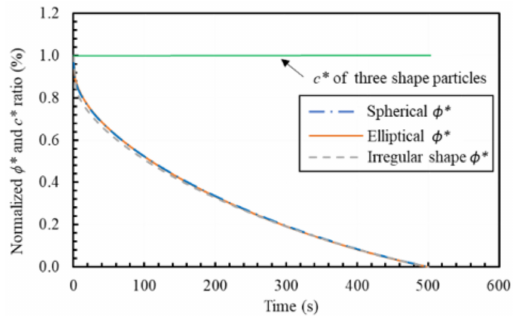
Figure 9. Evolution of normalized φ ∗ and c ∗